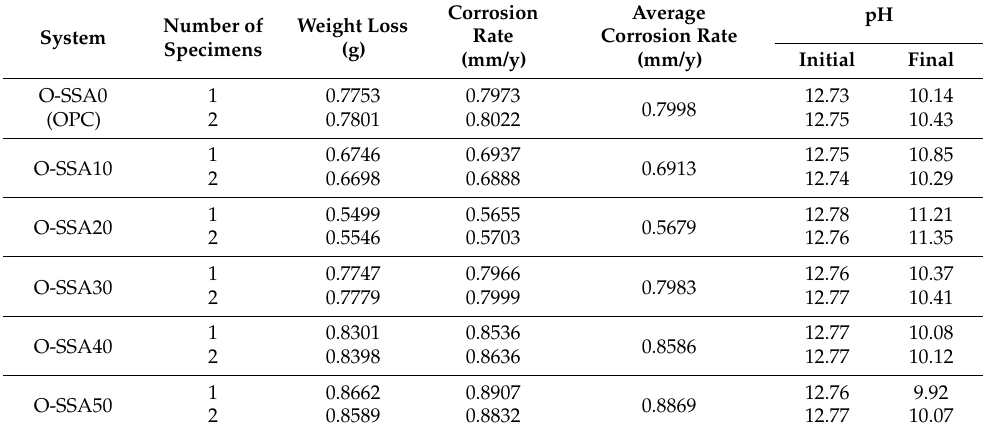
Table 6. Corrosion rate for steel rebars in various cement extracts obtained from gravimetric weight loss